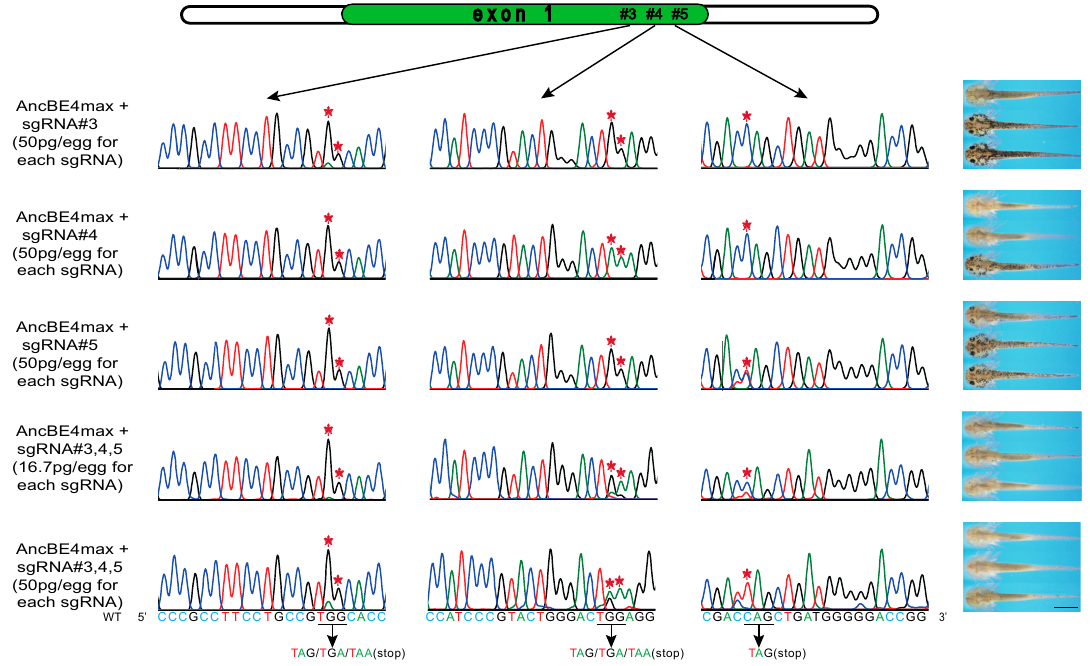
Figure 3. Multiplex sgRNAs could improve the tyr knockout efficiency. The single sgRNAs or multiplex sgRNAs were co-injected with the base editor mRNA into the fertilized eggs and the genotyping and phenotyping were performed 13 days later. The PCR sequencing chromatogram of the three editing sites from the same animal were shown in the left panels. The representative pictures of animals were shown in the right panels. The base pair conversions could be detected in all three editing sites of the individuals with the multiplex sgRNAs injected. Asterisks (*) indicate the base pair conversions. Scale bar: 2 mm.